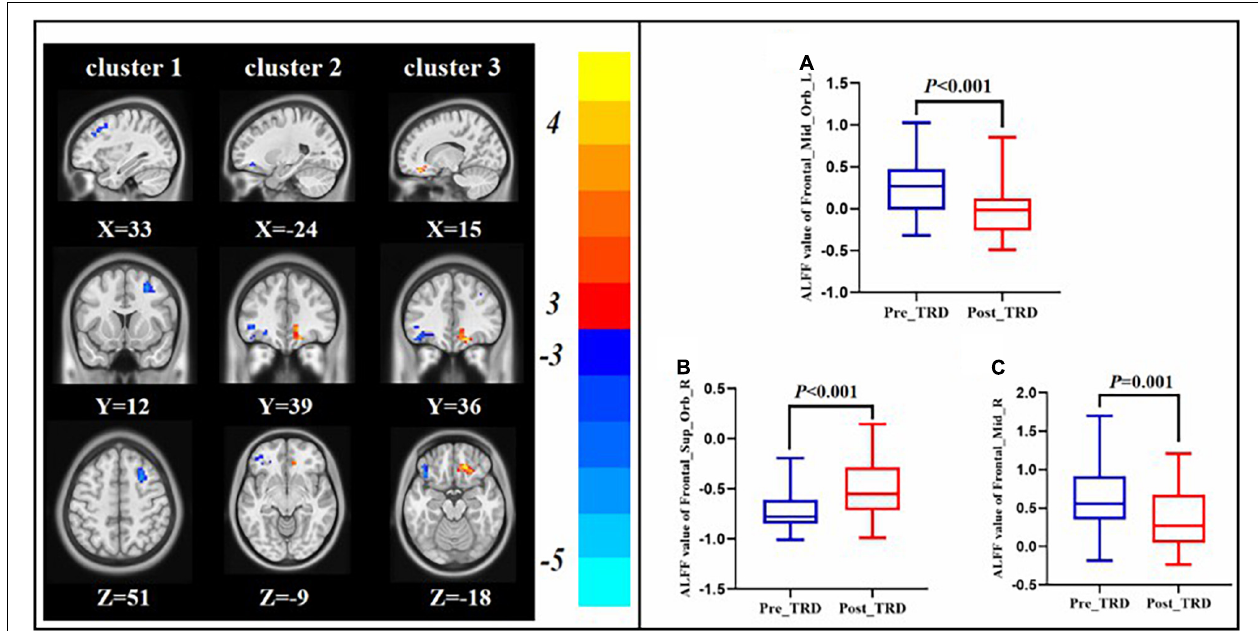
FIGURE 4 | Changes in ALFF between the post-treatment and pre-treatment. ALFF value of left orbital area of the middle frontal gyrus (A) , right orbital area of the superior frontal gyrus (B) , right middle frontal gyrus (C) .